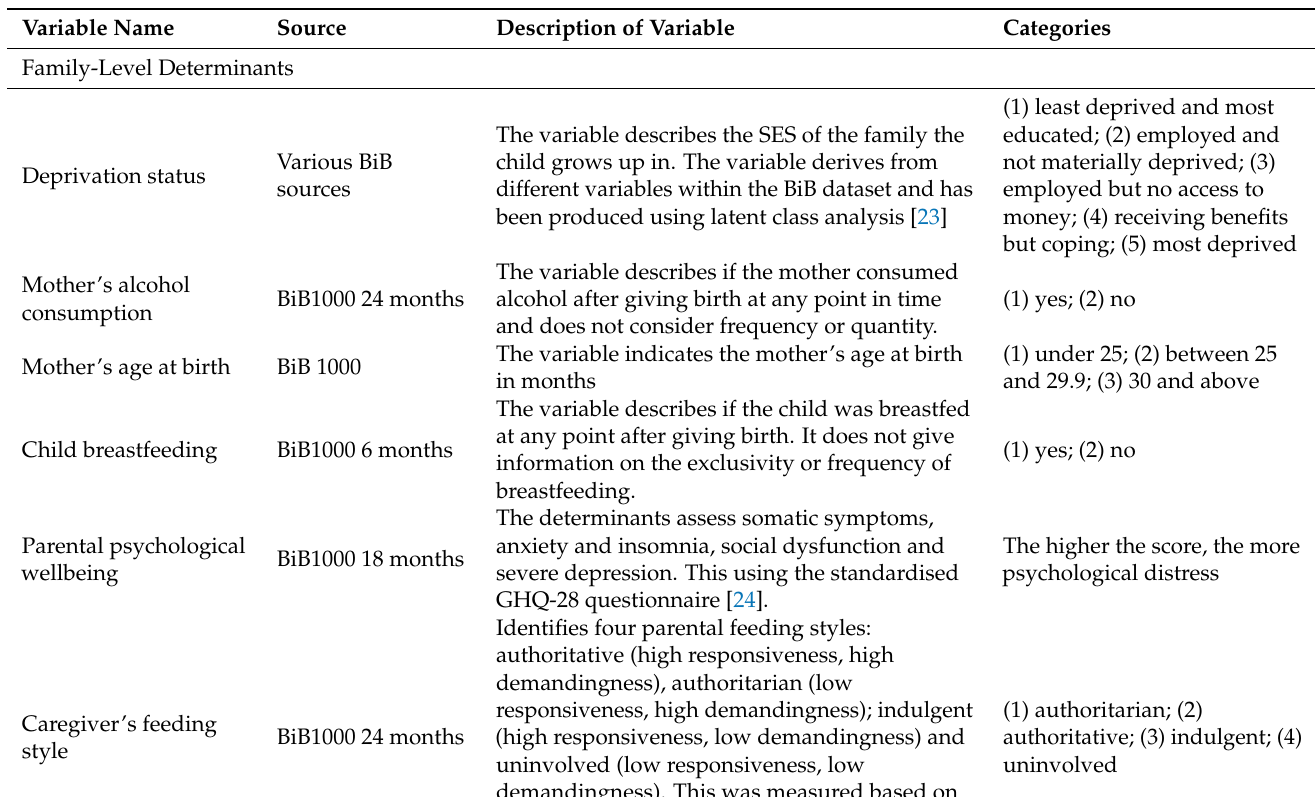
Table 1. Family and child-level determinants included in this